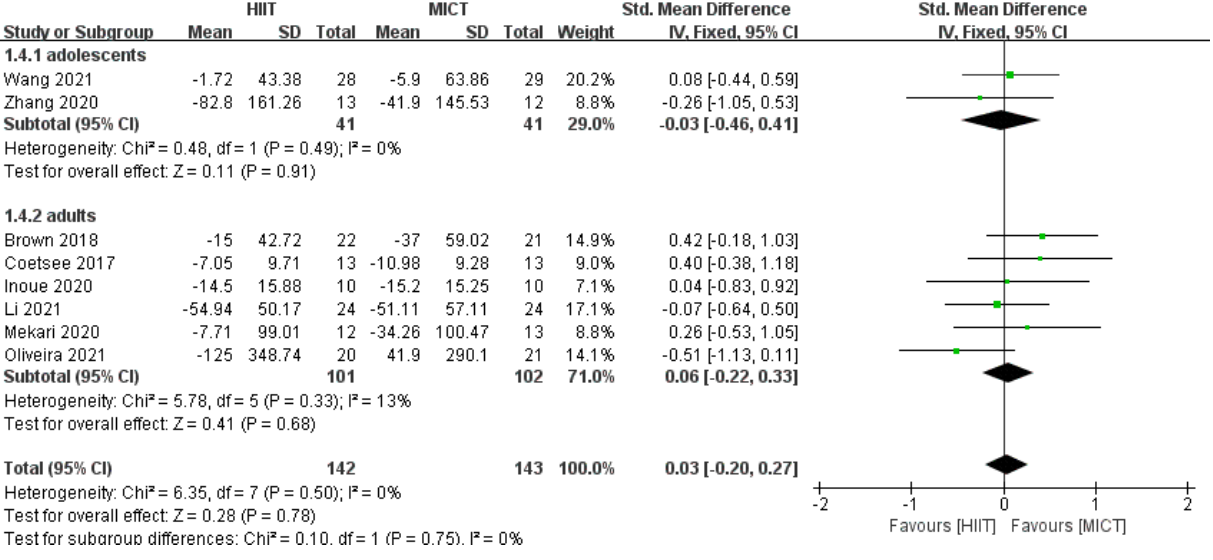
Figure 7. Subgroup analysis of HIIT and MICT for correct rate in the intervention population [24,25,34,36].